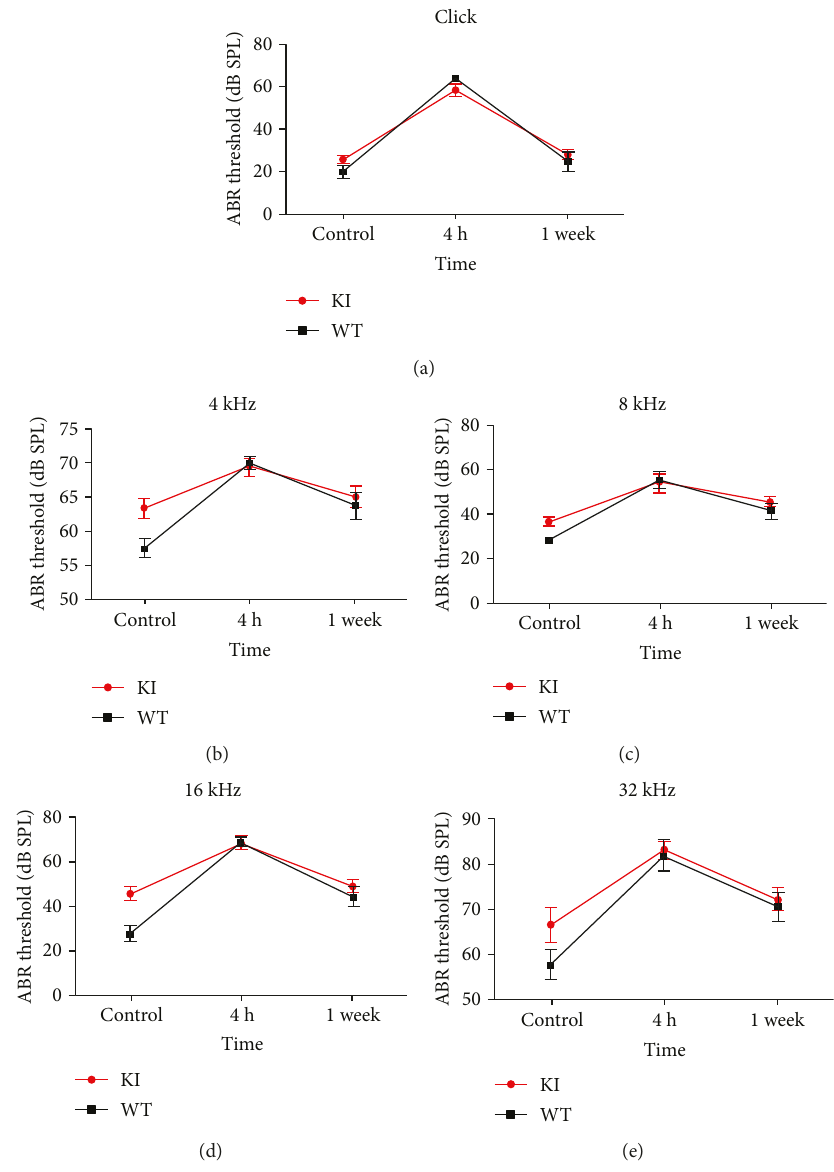
Figure 7: ABR analysis in Myo3a mutant and wide-type mice after noise exposure. ABR threshold was tested for broadband click (a) and frequency-speci fi c pure tone (b, c, d, e) on Myo3a mutant and wide-type mice before (control), 4 h after, and 1 week after noise exposure ( n ≧ 7 ); error bars indicate